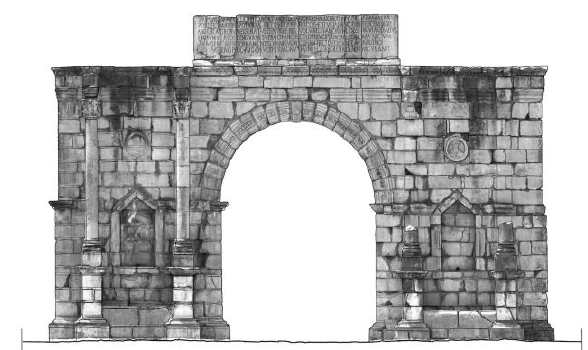
Figure 9. Orthophoto of the eastern elevation (from the 2017 survey).